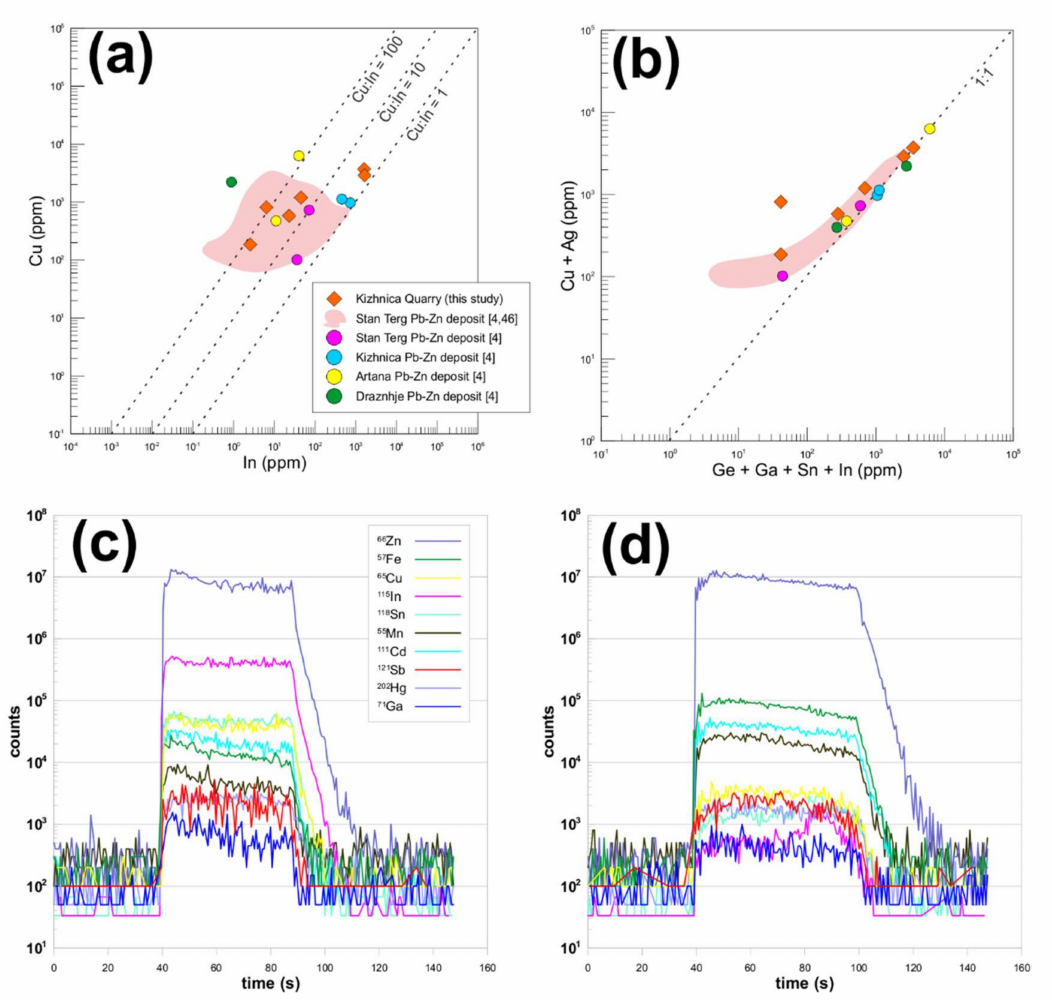
Figure 12. Binary plots showing the chemical composition of sphalerite from the Kizhnica quarry and selected Pb-Zn deposits from Kosovo ( a,b ) [4,46]; selected time-resolved laser ablation ICP-MS depth profiles of sphalerite from the Kizhnica quarry ( c,d ): ( a ) Cu vs In (in ppm); ( b ) Cu+Ag vs Ge+Ga+Sn+In (in ppm); ( c ) flat spectra of In,Sn,Cu-rich sphalerite; ( d ) flat spectra of